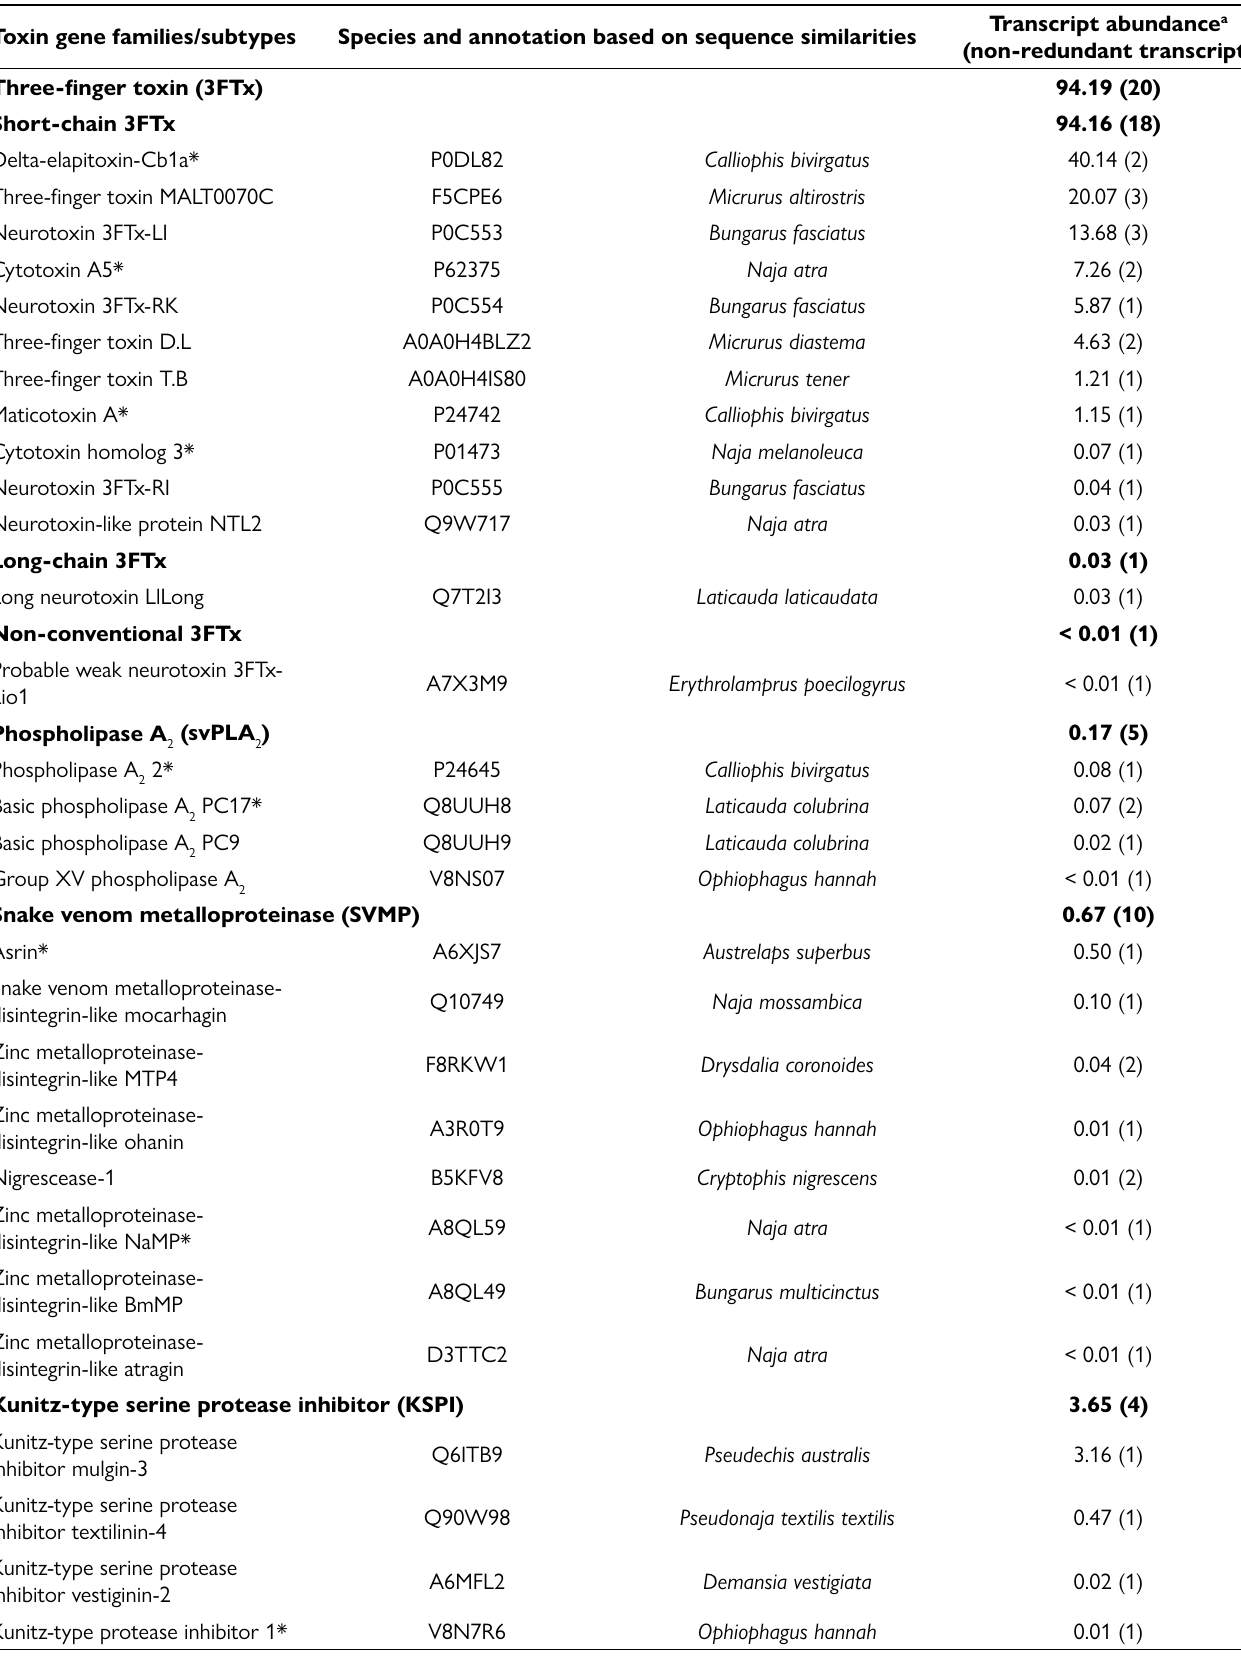
Table 2. Overview of toxin gene families and subtypes in the venom gland transcriptome of Calliophis bivirgata flaviceps